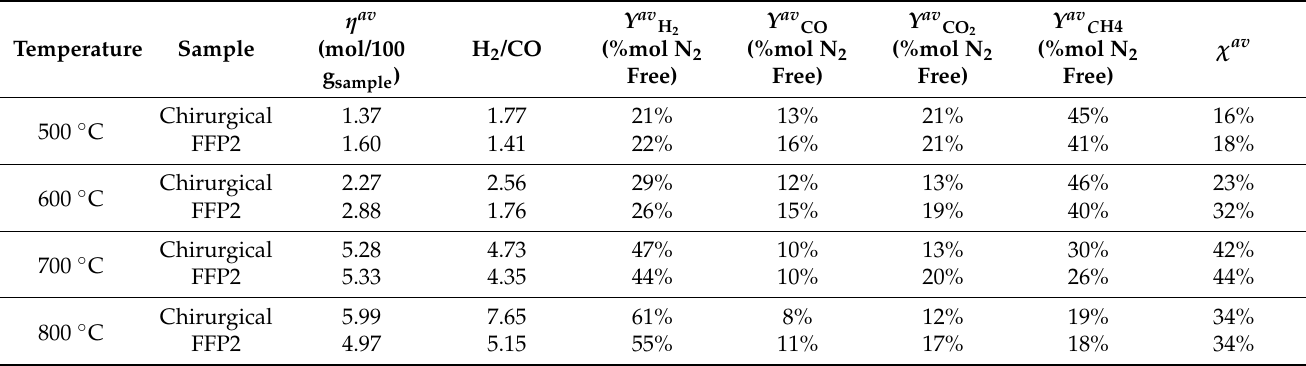
Table A3. Average values of pyrolysis parameters in N 2 and air atmosphere for wetted